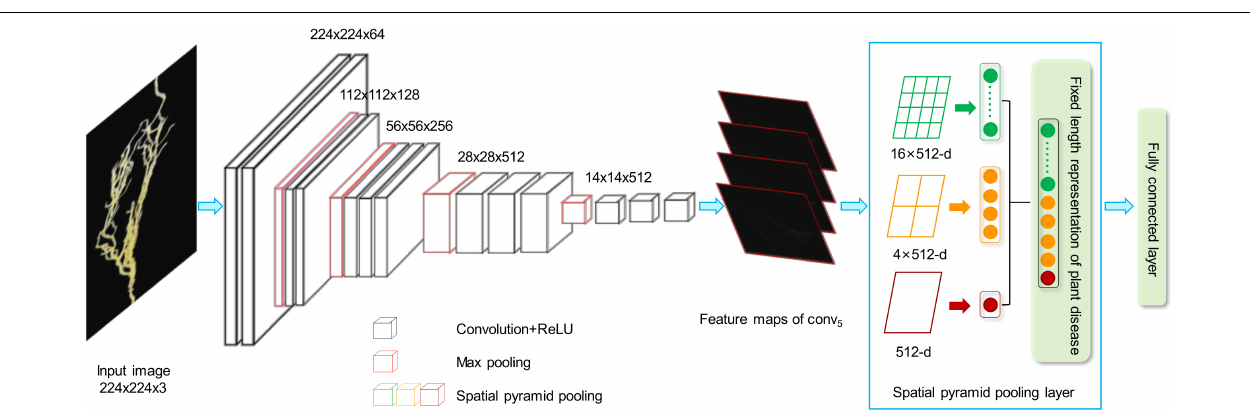
FIGURE 2 | CNN-based network for feature extraction. ReLU, Rectified Linear Unit; CNN, convolutional neural